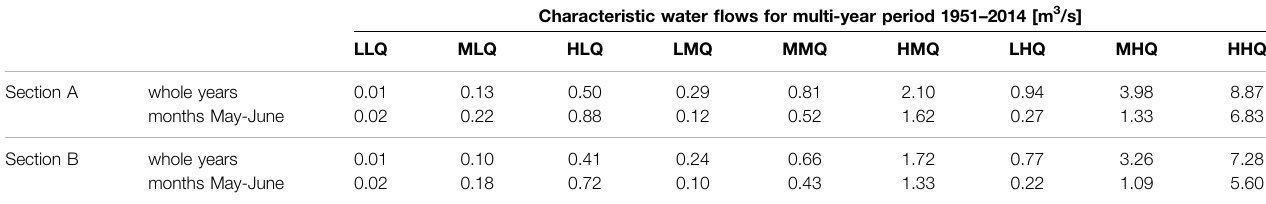
TABLE 1 | Characteristic fl ows from the multi-year period 1951 – 2014 for the studied sections, based on hydrological data from the Ryczywó ł water gauge. Characteristic water fl ows for multi-year period 1951 – 2014 [m 3 /s]